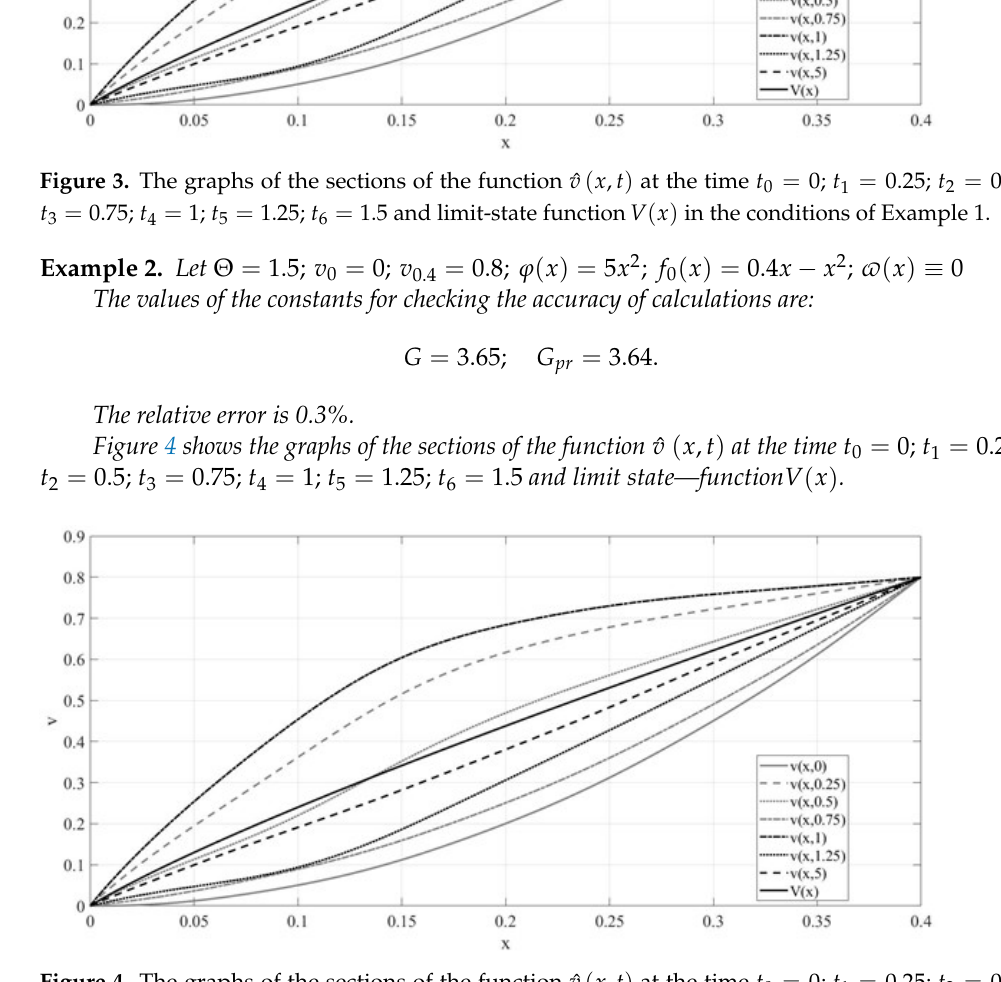
Figure 4. The graphs of the sections of the function ˆ v ( x , t ) at the time t 0 = 0; t 1 = 0.25; t 2 = 0.5; t 3 = 0.75; t 4 = 1; t 5 = 1.25; t 6 = 1.5 and limit-state function V ( x ) in the conditions of Example